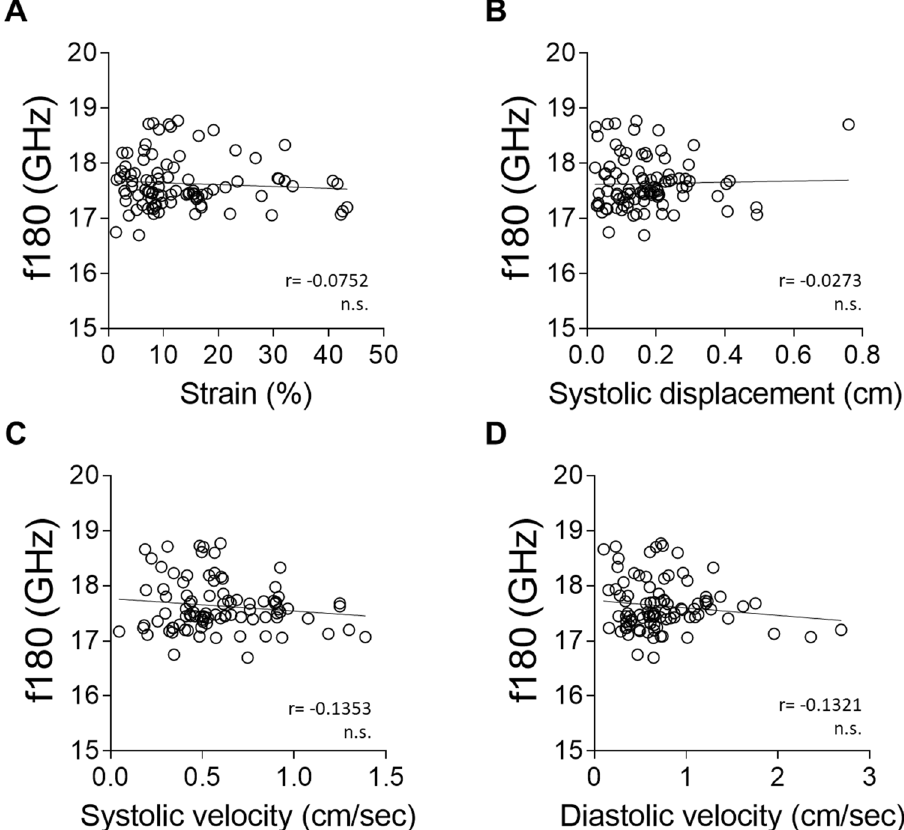
Figure 7. The correlation between Brillouin frequency shifts and radial wall deformation and motion indexes measured by echocardiography is lost after myocardial infarction. ( A – D ) Correlation between mBS frequency shift and radial strain ( A ), radial systolic displacement ( B ), radial systolic velocity ( C ), and radial diastolic velocity ( D ) measured by 2D speckle tracking with echocardiography. Statistical analysis was performed using Pearson correlation coefficient